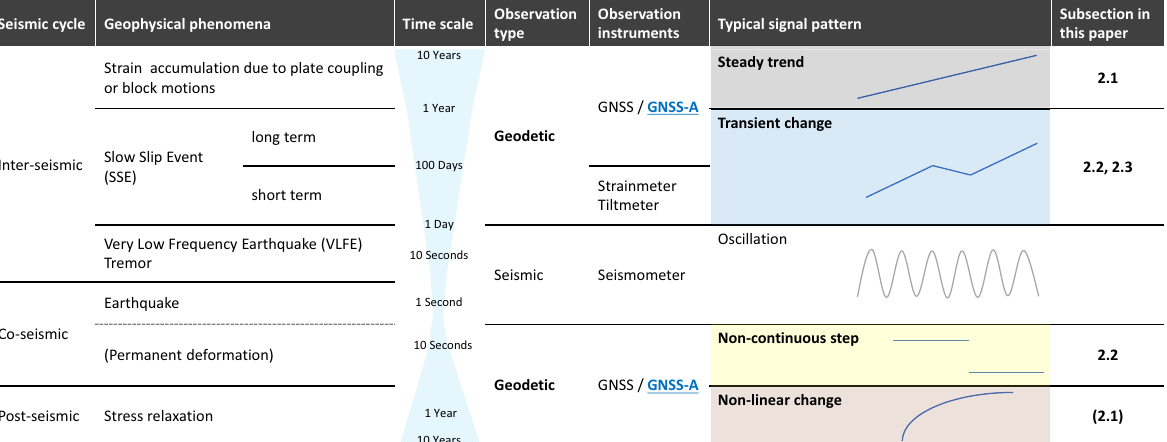
Table 1 Signals related to the earthquake